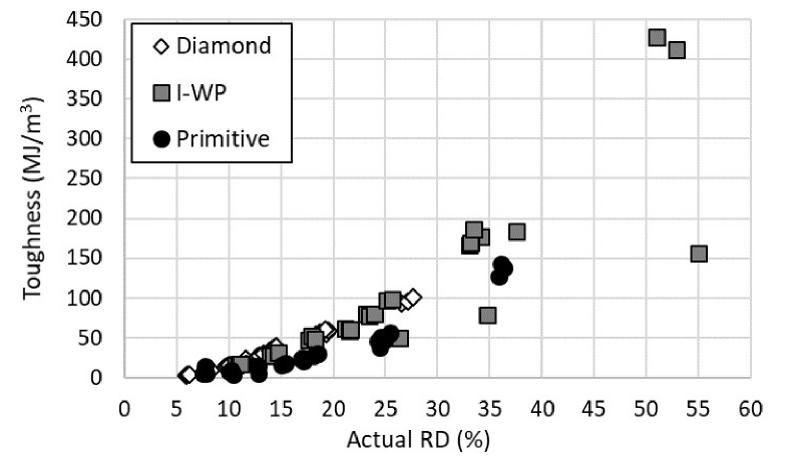
Figure 9. Toughness versus actual relative density of lattice